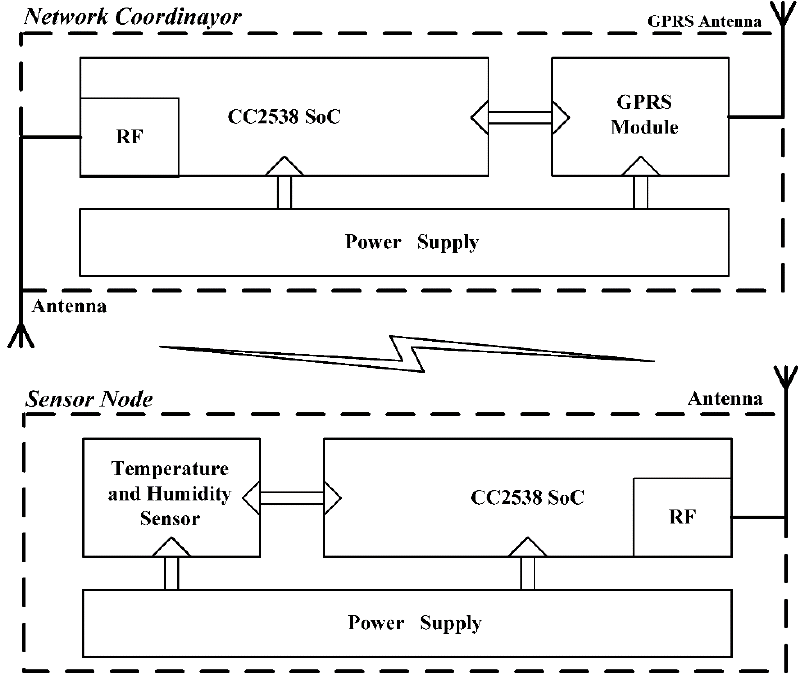
Figure 1. Diagram of the sensor node and network coordinator hardware. GPRS, general packet radio